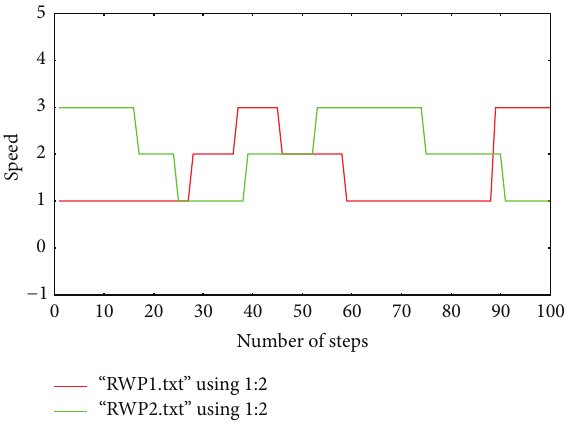
Figure 9: Speed of 2 mobile nodes without speed decay